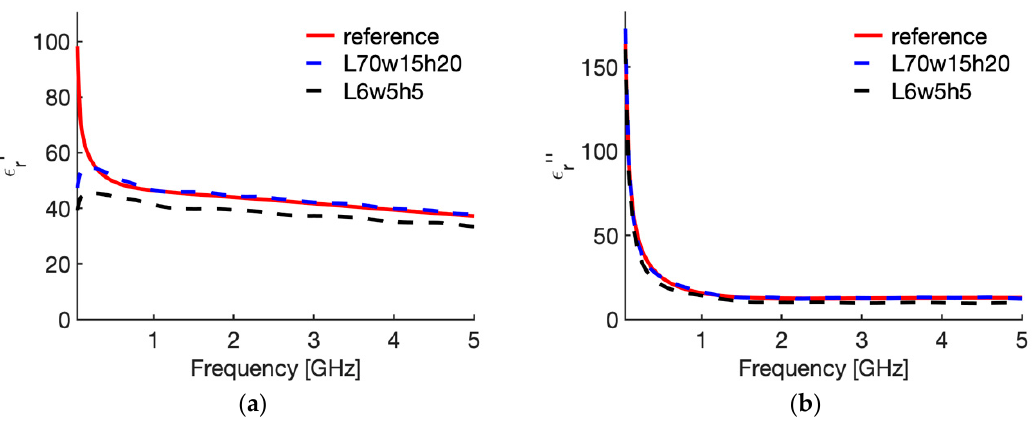
Figure 7. Relative complex permittivity of liver at 25 °C. ( a ) real part; ( b ) imaginary part. The values